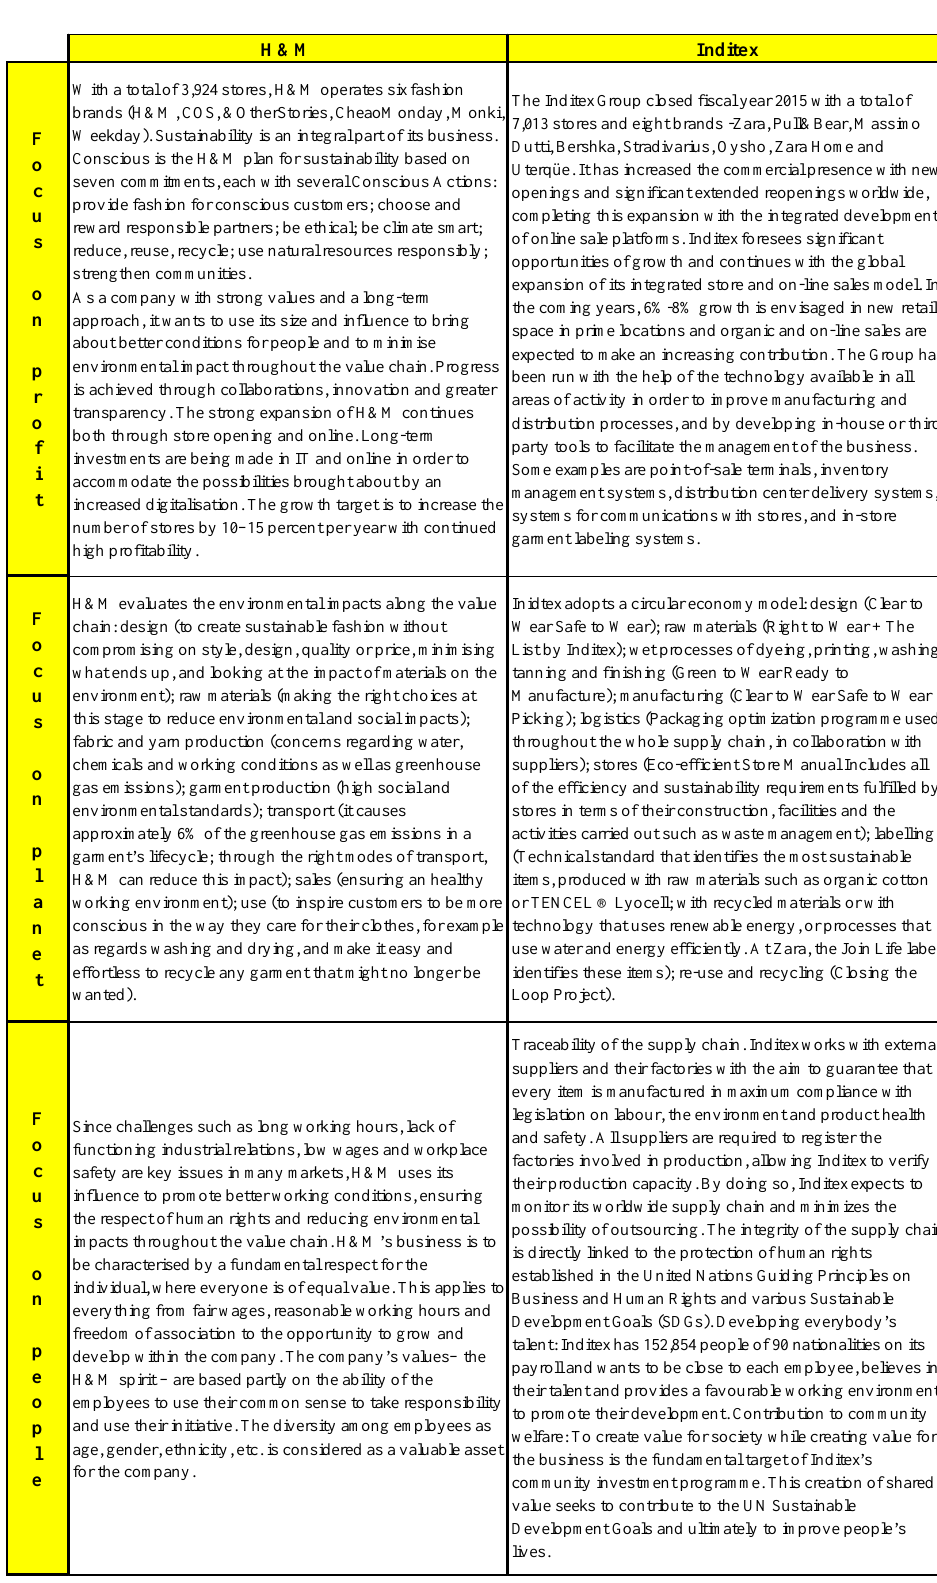
Table 2: Focus on profit, planet and people at Inditex and H&M H&M